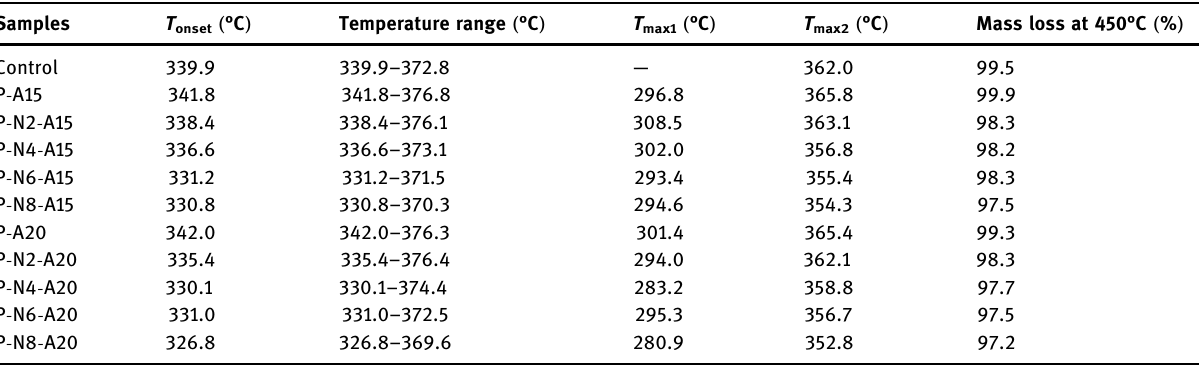
Table 3: TGA data of the PLA/NFC composites